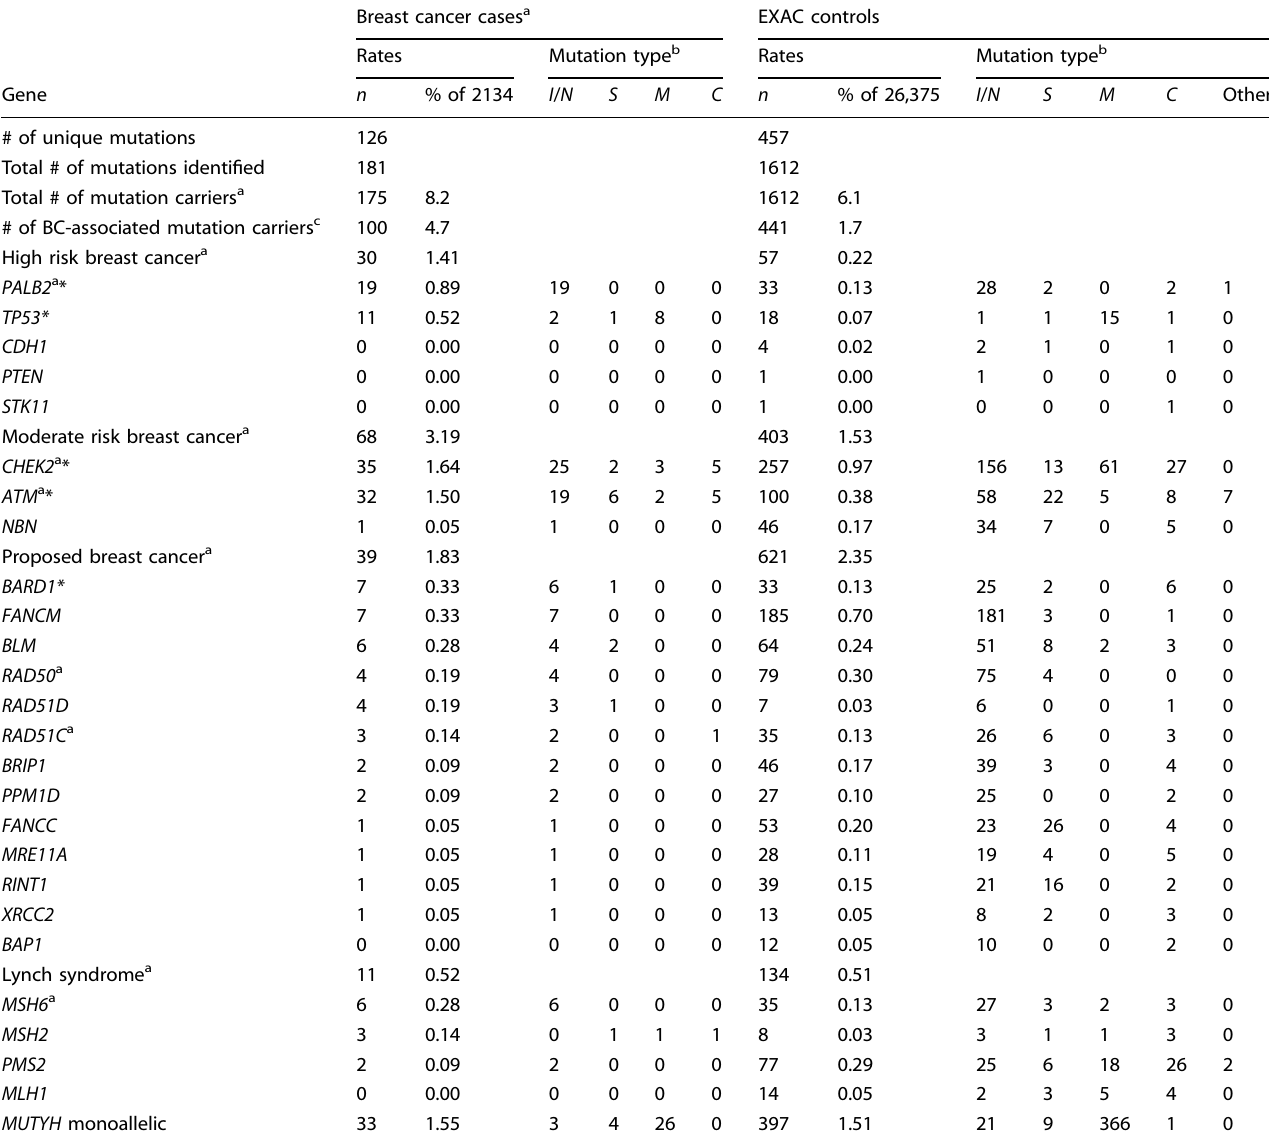
Table 2. Breakdown of types of pathogenic and likely pathogenic mutations identi fi ed in familial breast cancer women and ExAC